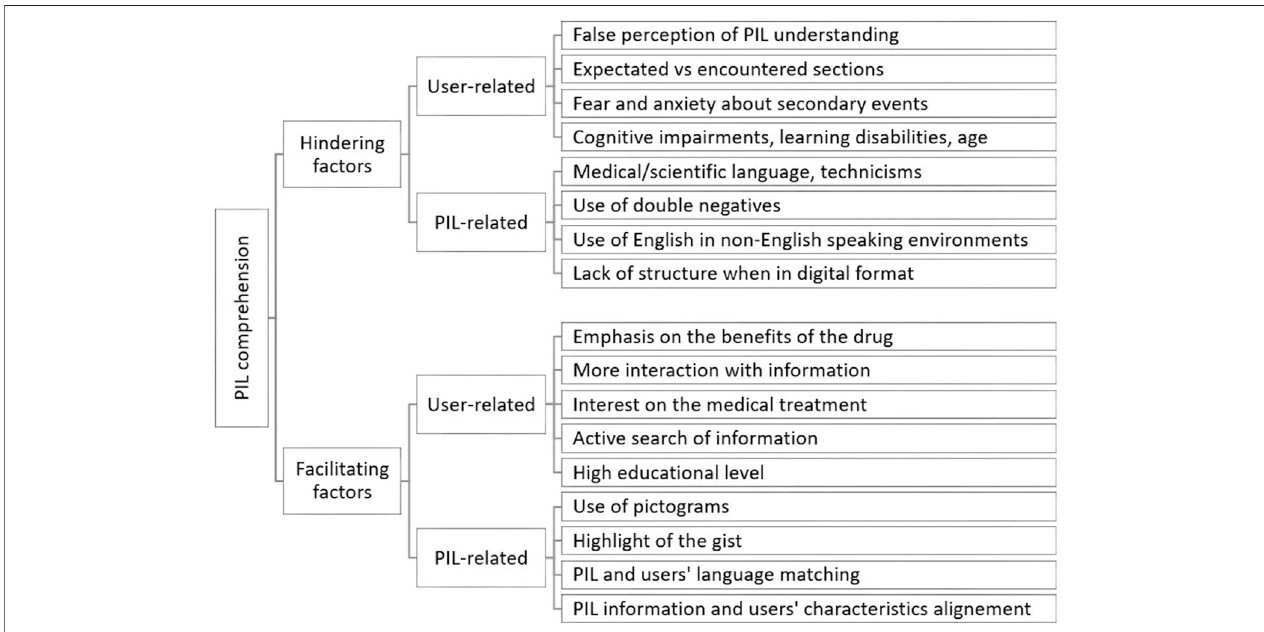
FIGURE 2 | Aspects that facilitate and hinder PILs comprehension. Diagram where it can be read “ PIL comprehension, ” “ Hindering fctors, ” “ Facilitating factors, ” etc.